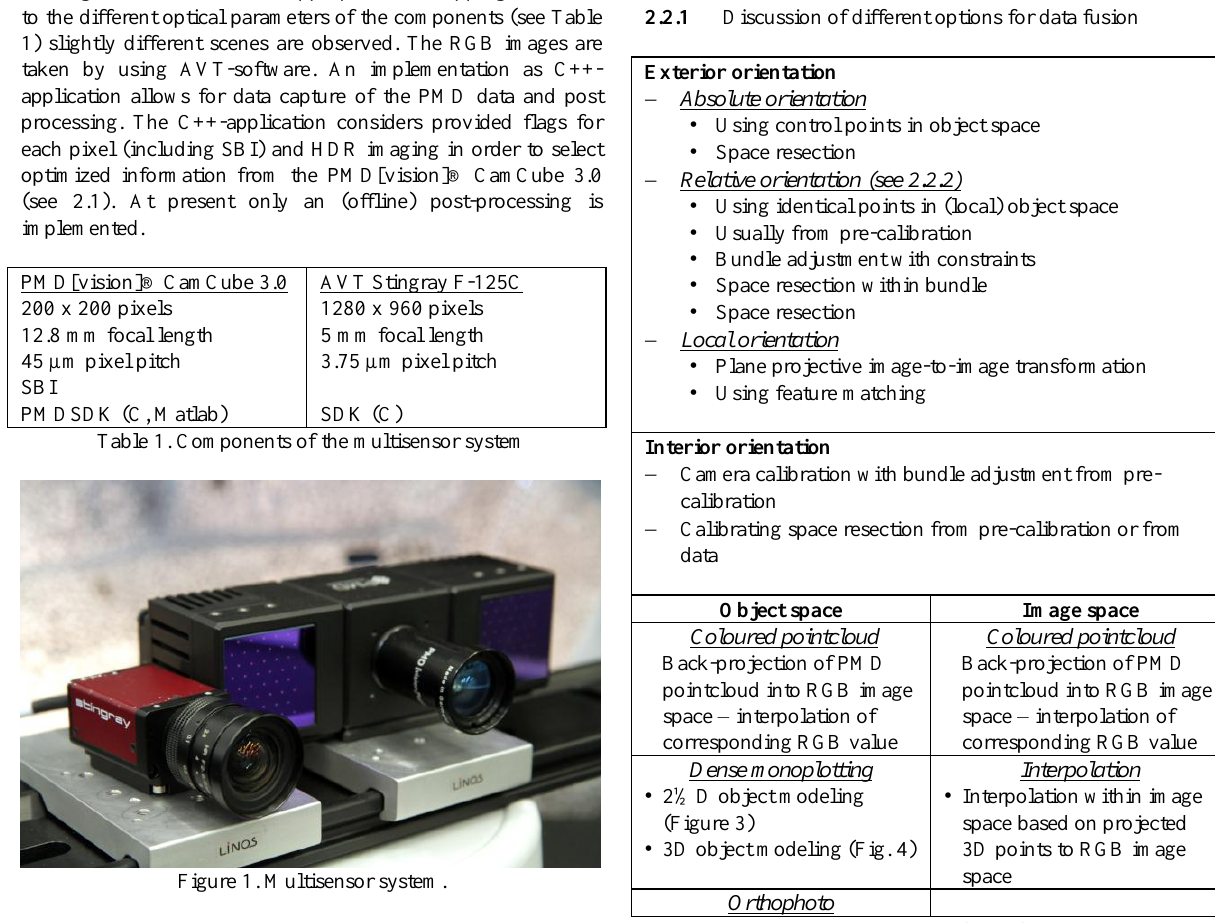
Table 2. Short summary of data fusion